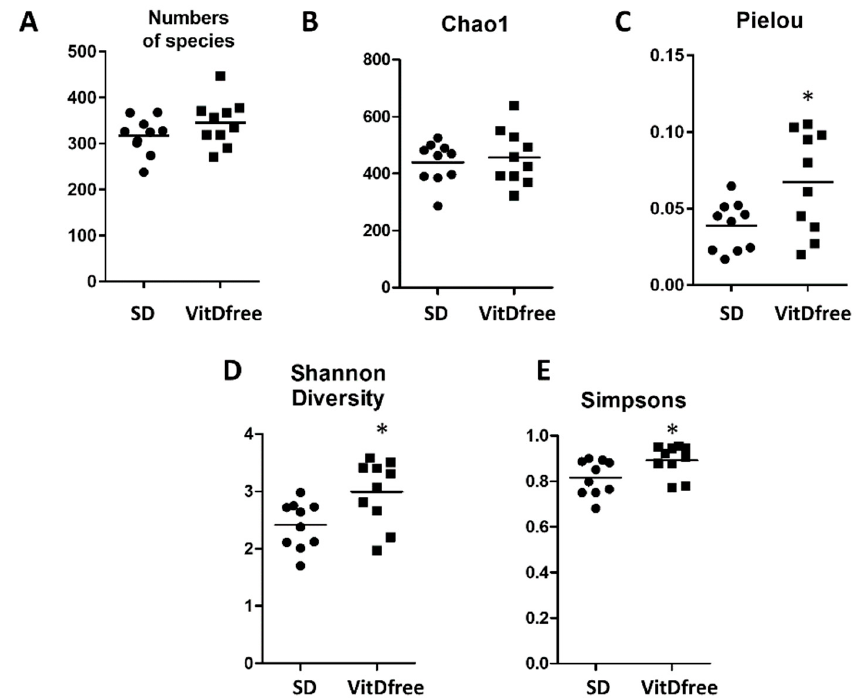
Figure 2. Effects of vitamin D-free diet on ecological parameters of the bacterial communities. Fecal samples were collected from standard diet (SD, n = 10) and vitamin D-free diet group ( n = 10) rats. The microbial alpha diversity was analyzed using ( A ) numbers of species, ( B ) Chao richness, ( C ) Pielou, ( D ) Shannon and ( E ) Simpsons indices. Results are expressed as a scatterplot and means and were compared by a student’s t-test; * p < 0.05 vs. SD.